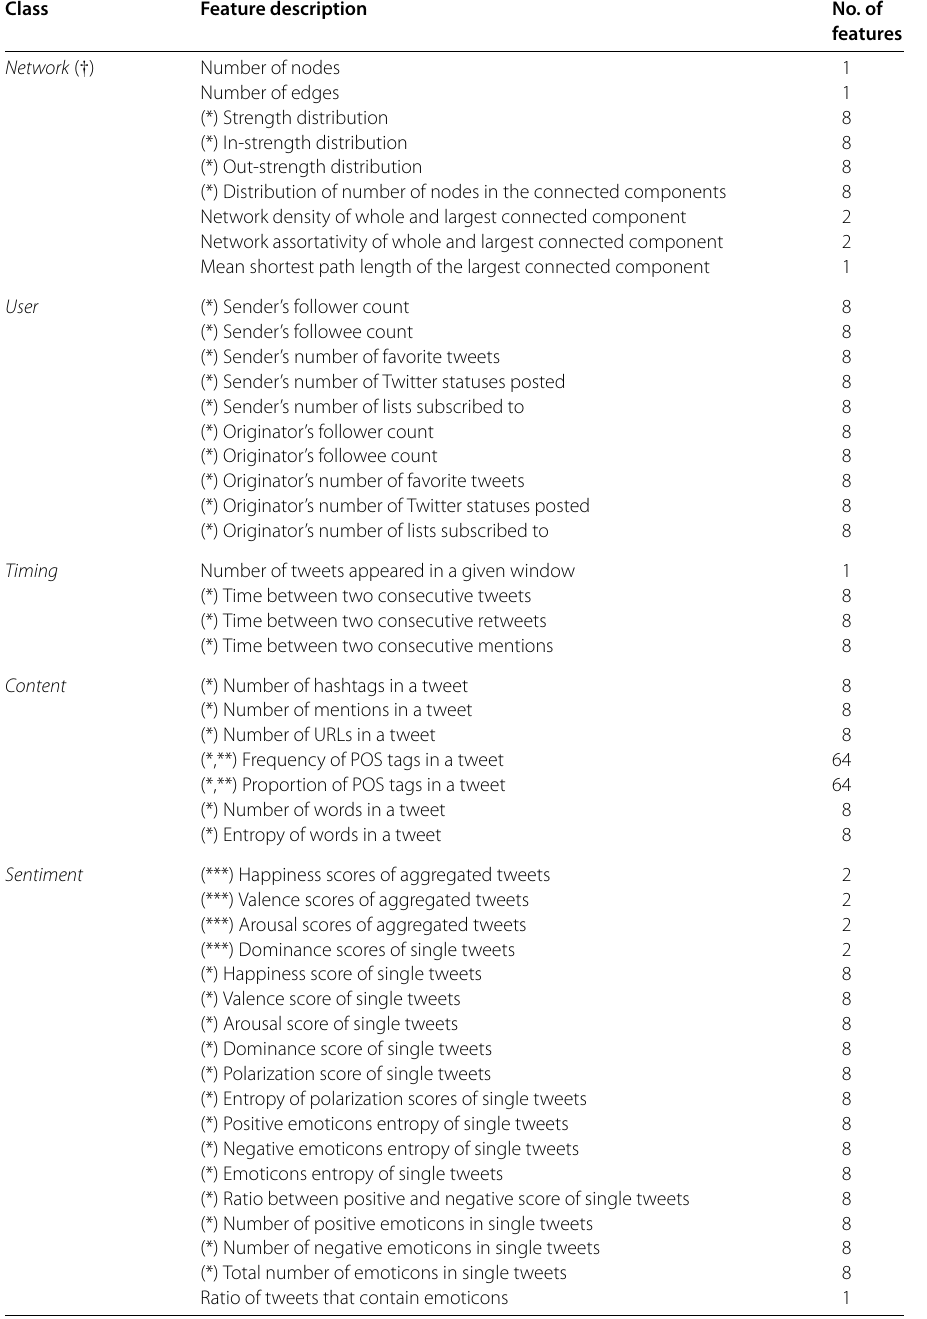
Table 2 List of 487 features extracted by our framework